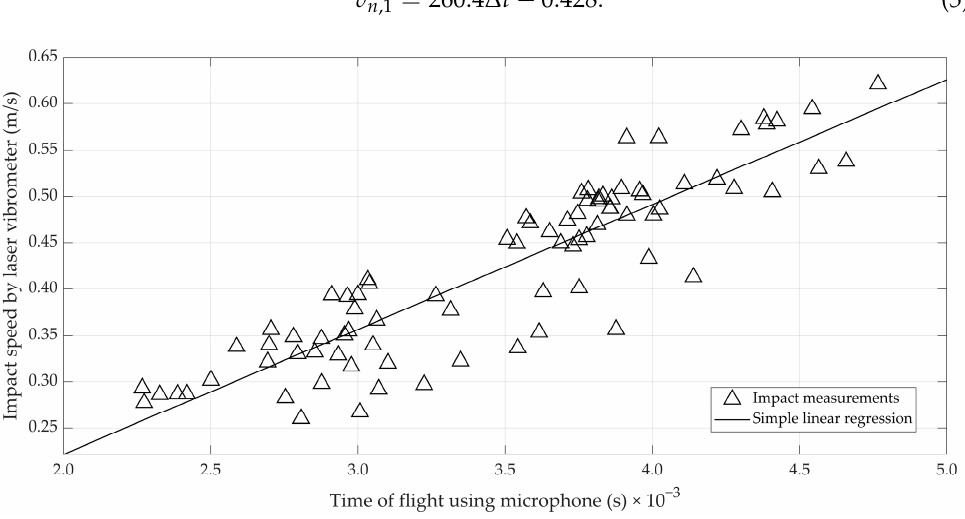
Figure 4. Scatterplot illustrating the relation between the time of flight of the bouncing ball estimated from the microphone signal and the impact speed measured with the laser vibrometer.